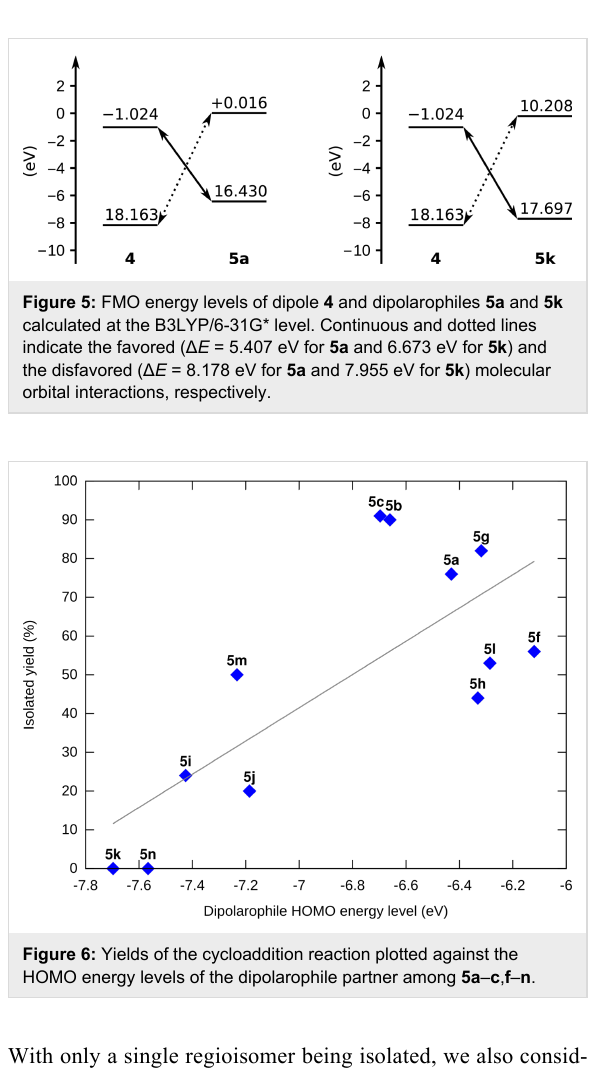
With only a single regioisomer being isolated, we also consid- ered the coefficients (Table 3) and shapes (Figure 4) of frontier molecular orbitals. This data is compatible with the observed